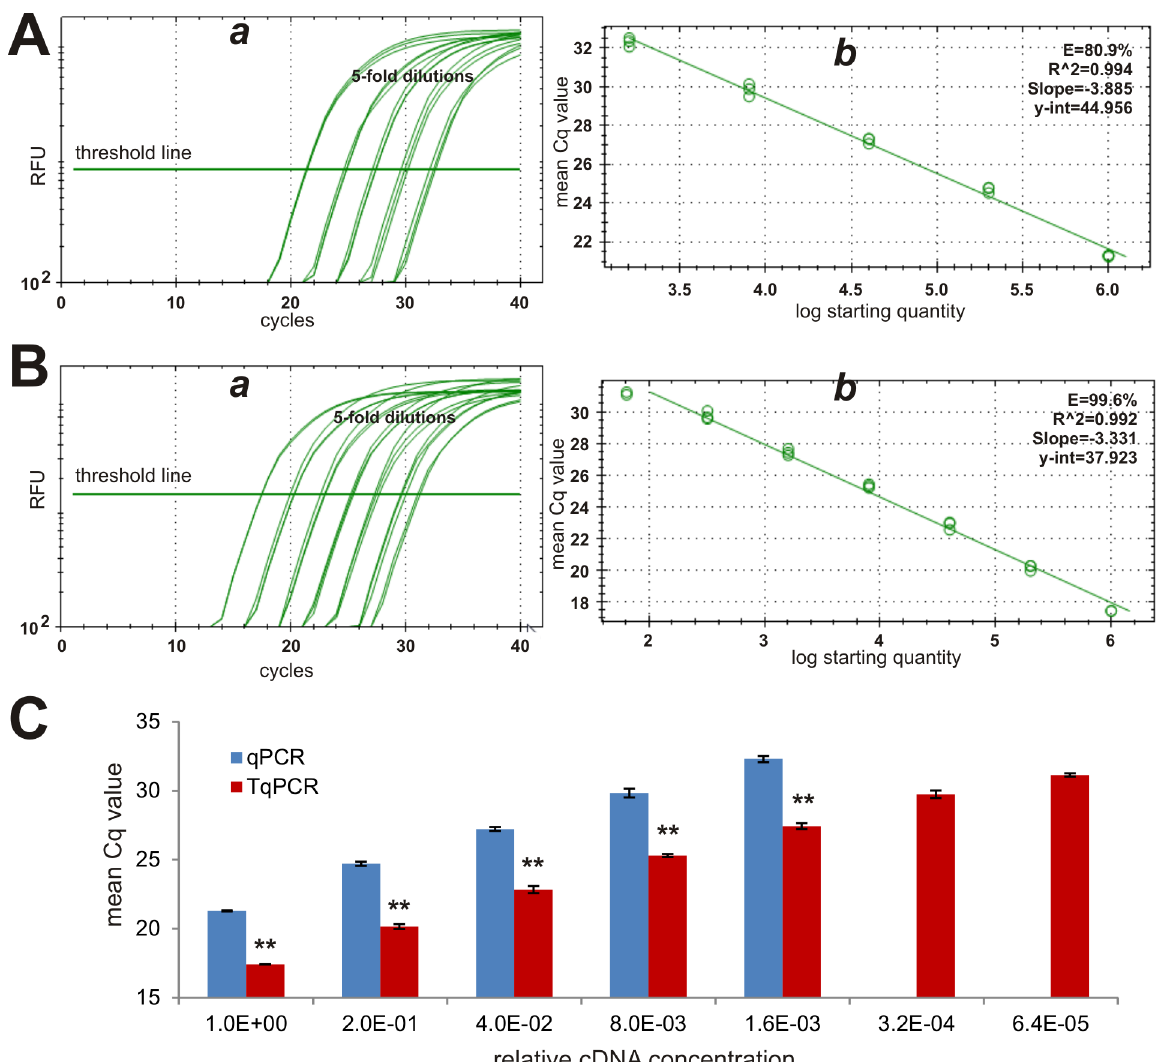
Fig 2. Comparative analysis of highly abundant reference gene Gapdh expression detected by conventional qPCR and TqPCR. The cDNA sample was prepared from the exponentially growing iMEF cells and was 5-fold serially diluted for PCR amplification. Primers specific for mouse Gapdh were used to detect Gapdh expression with the conventional qPCR (A) and TqPCR (B) protocols using CFX-Connect qPCR unit (Bio-Rad). The qPCR SYBR Green fluorescence history vs. cycle numbers ( a ) and the qPCR efficiencies of Gapdh ( b ) were analyzed and presented. The mean Cq value comparison of the two procedures was further graphed (C) . Note that the qPCR protocol did not yield reliable results for the two most diluted cDNA samples. “ ** ” , indicating the Cq difference between qPCR and TqPCR groups is significant with p <